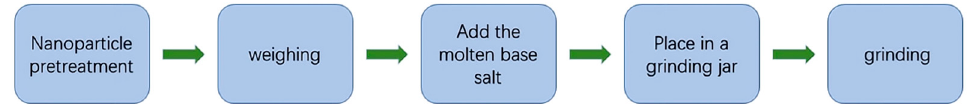
Figure 4. High-temperature melting preparation of molten salt nanofluidic flow [57].